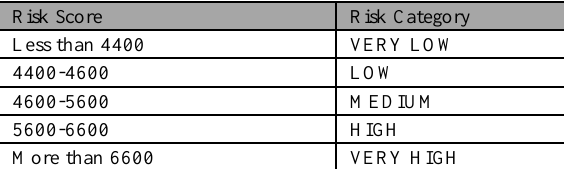
Table 6. The output factor used in the study.